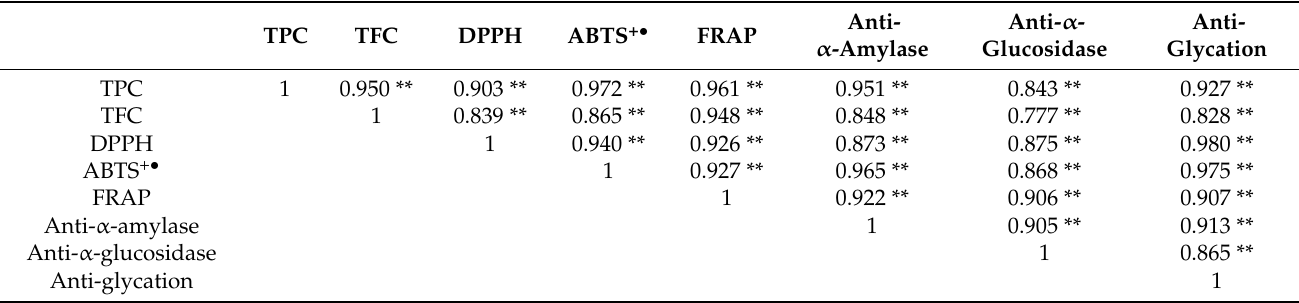
Table 5. Correlations among TPC, TFC, DPPH, ABTS + • , FRAP assay, anti- α -amylase, anti- α -glucosidase and anti-glycation of SPE in Nangsew strains.